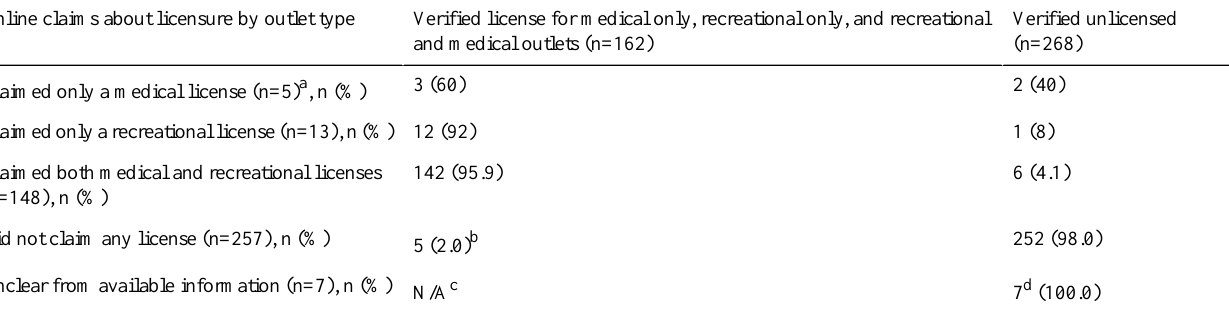
Verified unlicensed (n=268)Verified license for medical only, recreational only, and recreational